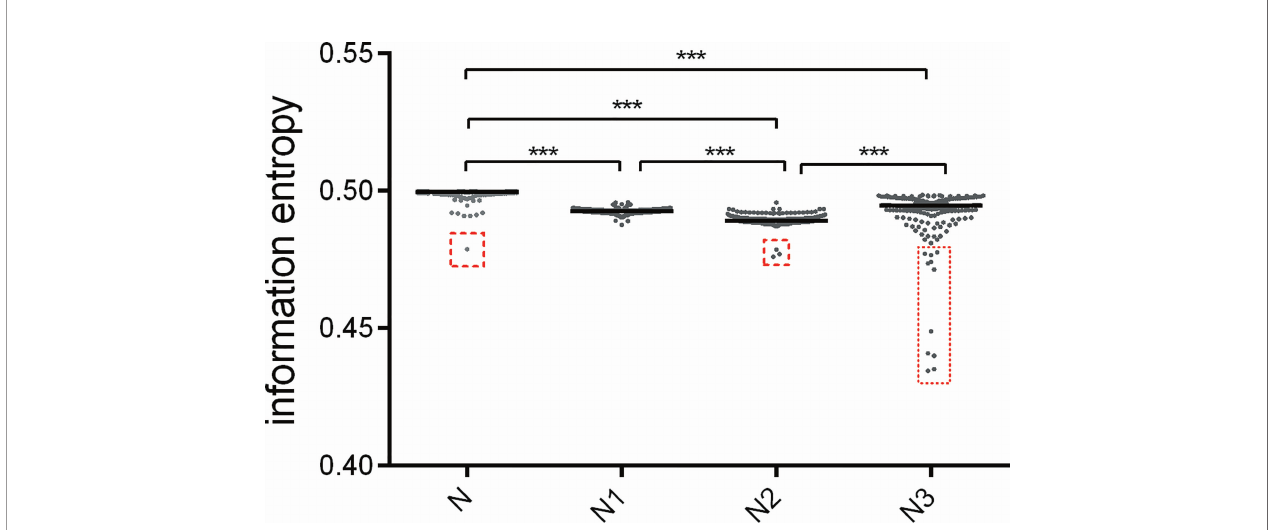
FIGURE 3 | The patterns of nucleotide usage bias for atg13 genes of 226 eukaryotic organisms are represented by information entropy. The ‘ N ’ means the overall nucleotide usage bias across the complete gene, The ‘ N1 ’ , ‘ N2 ’ , and ‘ N3 ’ stand for the patterns of nucleotide usage bias at the fi rst, second, and third codon positions, respectively. The red box with broken lines highlights the outliers which correspond to atg13 genes of the speci fi c organisms. *** means p -value < 0.001.